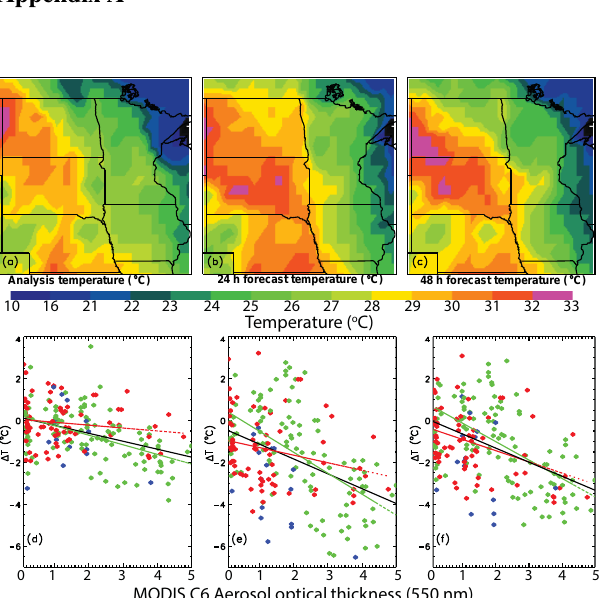
Figure A1. (a–c) 0, 24, and 48h forecasts of 1.5m air tempera- tures for the study region as shown in Fig. 3a at 18:00UTC, 29 June 2015, from UKMO model runs. (d–f) The differences between sur- face observations (using ground stations as shown in Fig. 3c) and UKMO-modeled 1.5m temperatures (at 18:00UTC, 29 June 2015) as a function of Collection 6 Terra MODIS DT τ 550 . Data pairs are colored based on the observed monthly mean surface tempera- tures at 18:00UTC as shown in Fig. 3g. Data pairs for regions with monthly mean temperatures of <22 ◦ C, between 22 and 24.5 ◦ C and >24.5 ◦ C are colored in blue, green, and red respectively. Red dashed lines are the linear fit lines to the data pairs with red col- ors, and green dashed lines are the linear fit lines for data pairs with green colors.